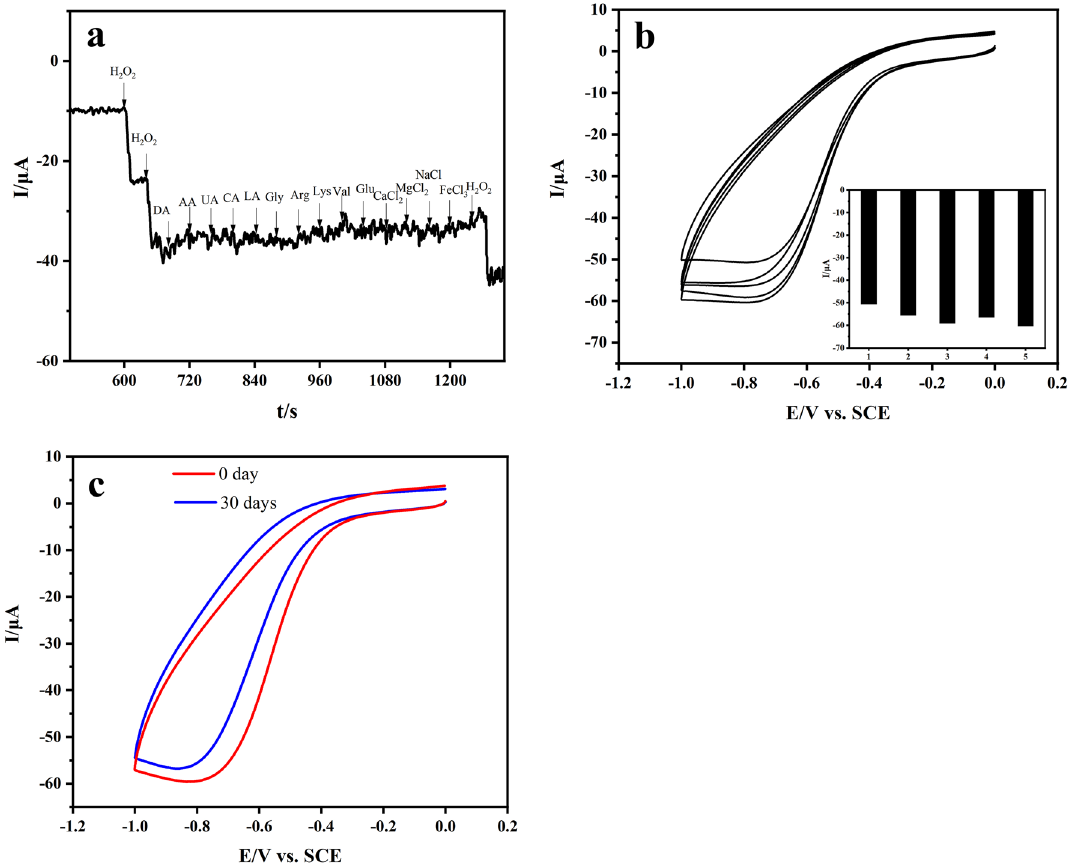
Figure 8. ( a ) Amperometric response recorded at Cu x O/Ag@FLG/GCE in 0.01 M PBS with the additions of H 2 O 2 (1 mM), DA, AA, LA, Gly, UA, Arg, Lys, CA, Val, Glu, CaCl 2 , MgCl 2 , NaCl, FeCl 3 ; ( b ) CV curves of Cu x O/ Ag@FLG/GCE in 0.01 M PBS contained 4 mM H 2 O 2 at five equally prepared Cu x O/Ag@FLG/GCE sensors; ( c ) CV curves of the Cu x O/Ag@FLG/GCE in PBS contained 4 mM H 2 O 2 tested at 1st day and 30th day. Modified